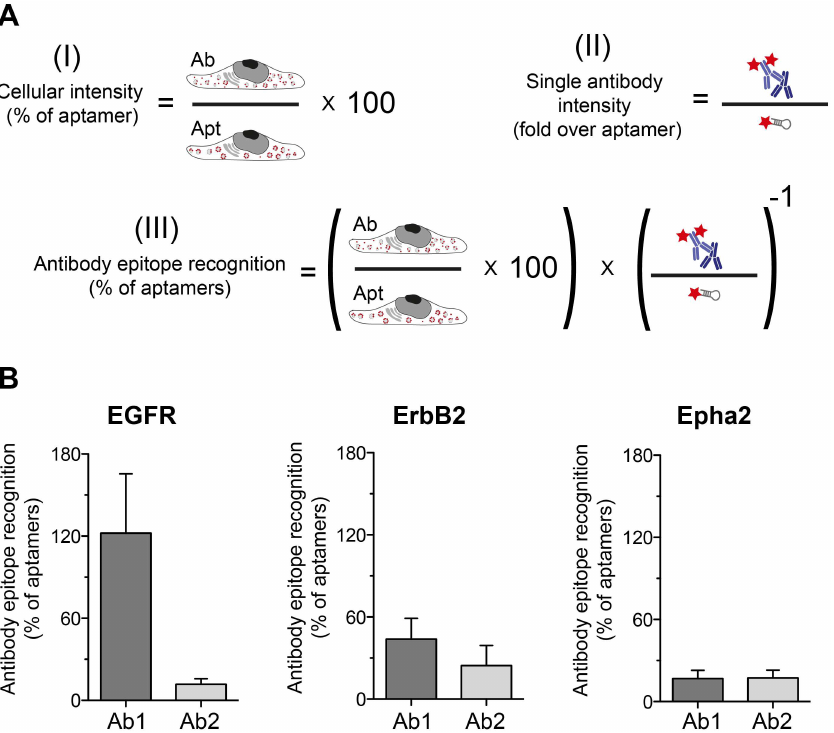
Fig 5. Estimations of the ability of antibodies or aptamers to recognized their epitopes. (A) Scheme explaining how the epitoperecognitionestimationwas calculated. (I) Cellularintensity (% of aptamer) is the data also displayedin Fig 3B. (II) Intensity of single antibody packageexpressedas fold over the aptamer intensity is the data on Fig 4A–4C.(III) If we know the signal contribution of a single antibody packageto the total cellularstaining, we can estimate how many epitopeswere found by the antibodiesin relation to the epitopes found by the aptamers. ( B ) The results of the equation (III). Error bars represent the SEM from at least 3